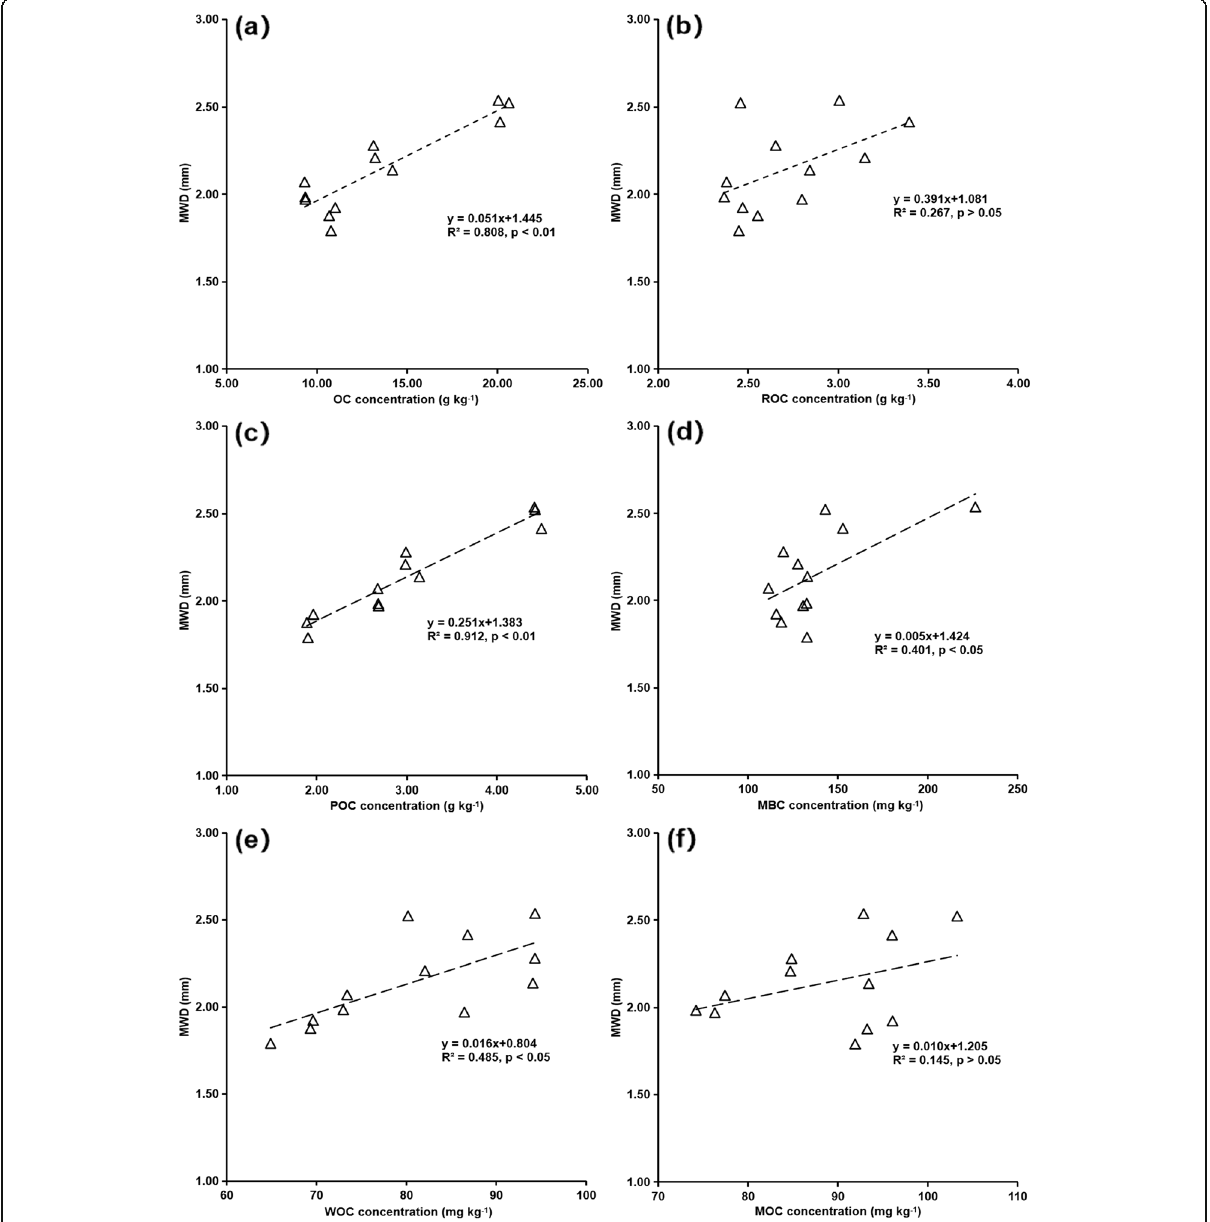
Fig. 3 Relationships of soil aggregate stability (as indicated by the MWD) with the carbon concentration in a chronosequence of Chinese fir plantations. MWD, mean weight diameter; OC, organic carbon; ROC, readily oxidizable carbon; POC, particulate organic carbon; MBC, microbial biomass carbon; WOC, water-soluble organic carbon; MOC, mineralized organic